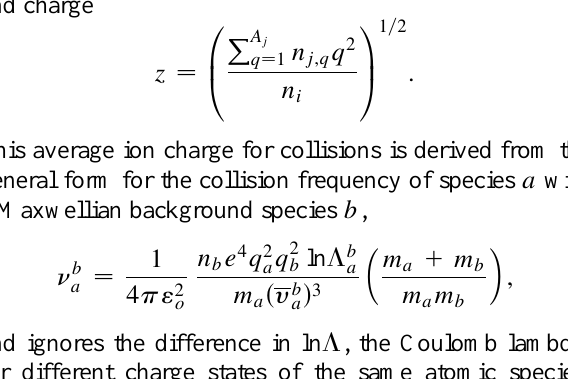
FIG. 1. (Color) Comparison of CSD predictions for a pure Ne plasma when using the Lotz or Müller formulas for an electron collisional ionization cross